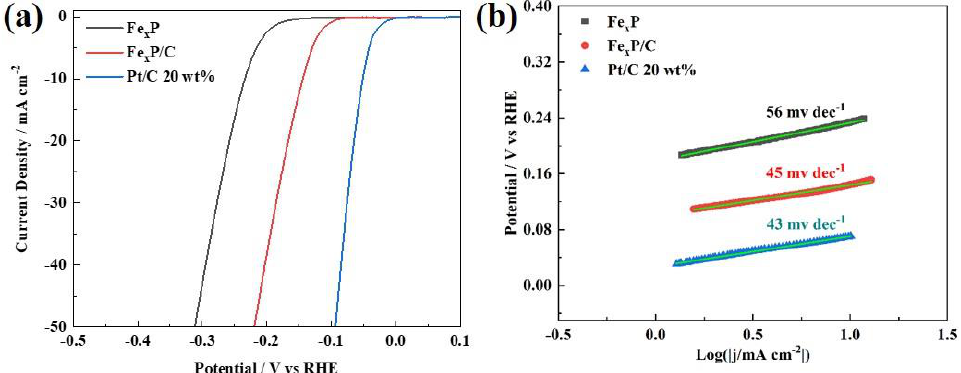
Figure 3. ( a ) LSV curves for 20 wt% Pt/C, FexP, and FexP/C in 1 M KOH; ( b ) the corresponding Tafel plot.